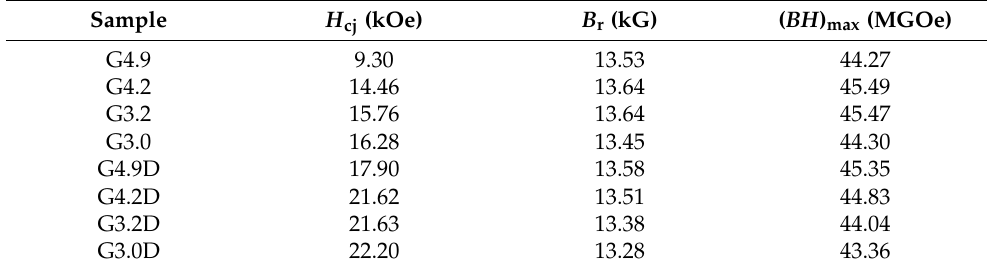
Figure 2. ( a ) The demagnetization curves of the original magnets (G4.9, G4.2, G3.2, and G3.0) and the diffused magnets (G4.9D, G4.2D, G3.2D, and G3.0D) with different grain sizes; ( b ) the coercivity of magnets with different grain sizes before and after the diffusion process (the red bars represent H cj for the original magnets, and the blue bars represent the increments of H cj after the diffusion process). Table 1. Coercivity, remanence, and maximum energy product of the magnets with different grain sizes before and after diffusion.